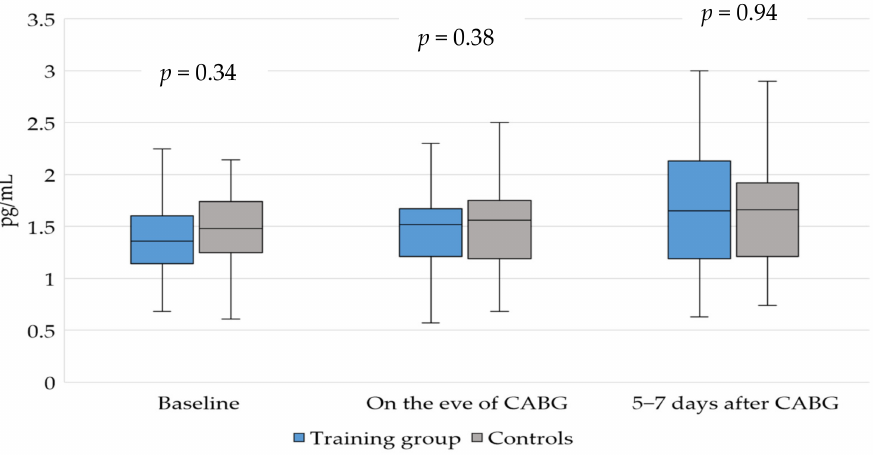
Figure 2. Changes in endothelin-1 concentration in the perioperative period for the patients undergo- ing elective coronary bypass surgery according to the approach to